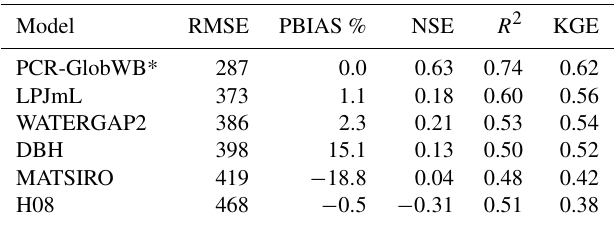
Table A4. The mean performance of GHMs, averaged over all climate forcing datasets and all 10 monitoring stations. It should be noted that PCR-GlobWB does not include a version forced with PGFv2, which in this basin has the highest